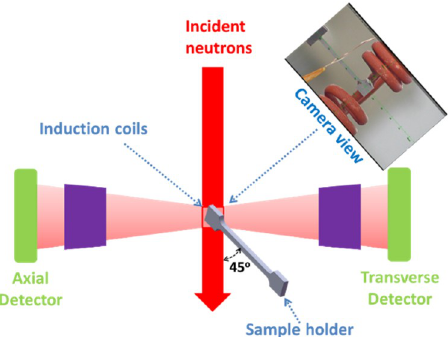
Figure 1. Schematic configuration of the real-time in situ neutron diffraction on the sample under heating by induction coils. The upper right inset shows the camera view of the heating set-up.